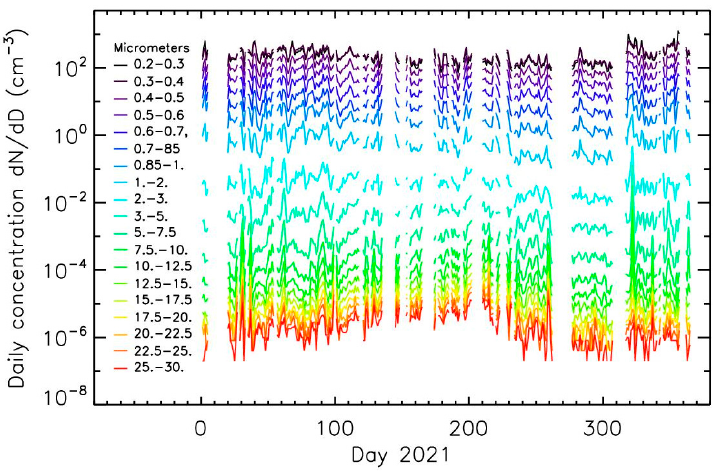
Figure 1. Daily time-evolution of particle concentrations for the 19 size classes measured by the LOAC optical counter in 2021 in the Park André Citroën in the south-west of Paris (France); pollen grains can be present in size classes > 15 µm.